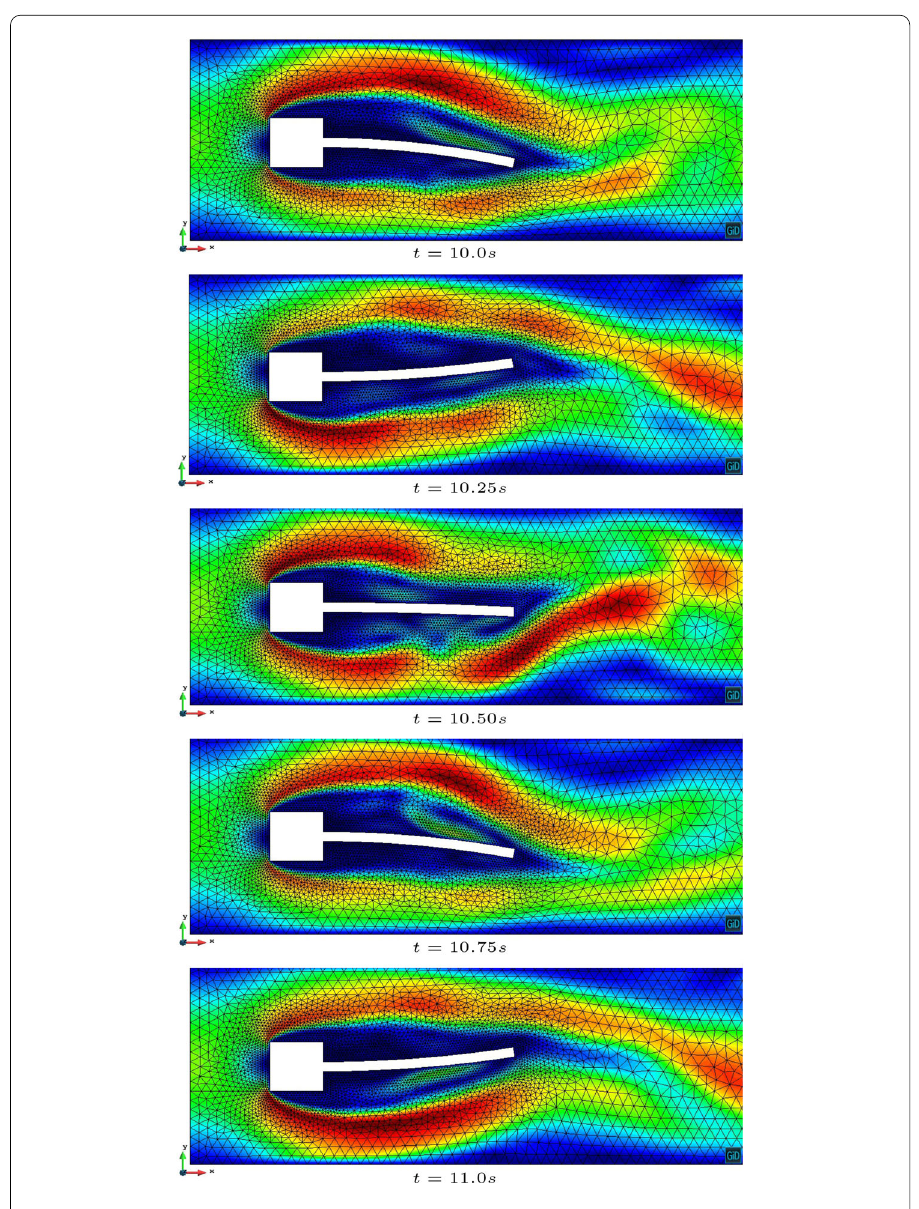
Fig. 7 Deformed structure with velocity contours and deformed finite element mesh for the numerical experiment from 10 . 0 to 11 . 0 s by snapshots in steps of 0 . 25 s